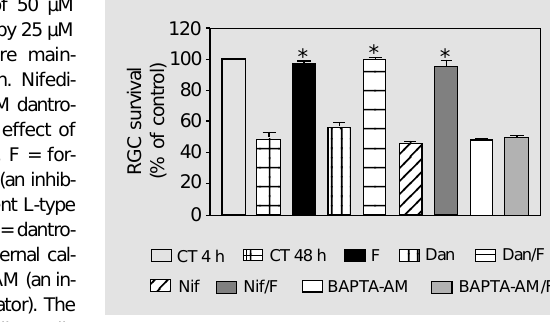
Figure 2. The effect of 50 µM forskolin was inhibited by 25 µM BAPTA-AM. Cells were main- tained in vitro for 48 h. Nifedi- pine (7.5 µM) and 30 µM dantro- lene did not block the effect of forskolin. CT = control, F = for- skolin, Nif = nifedipine (an inhib- itor of voltage dependent L-type calcium channels), Dan = dantro- lene (an inhibitor of internal cal- cium release), BAPTA-AM (an in- tracellular calcium chelator). The number of retinal ganglion cells (RGCs) counted in 4-h cultures was 13,350 cells. Data are reported as the percentage of RGC survival compared with 4-h control cultures (100%) and represent the mean ± SEM of three different experiments, each performed with at least three different Petri dishes (N = 3-6). *P<0.001 compared to the 48-h control (Newman-Keuls